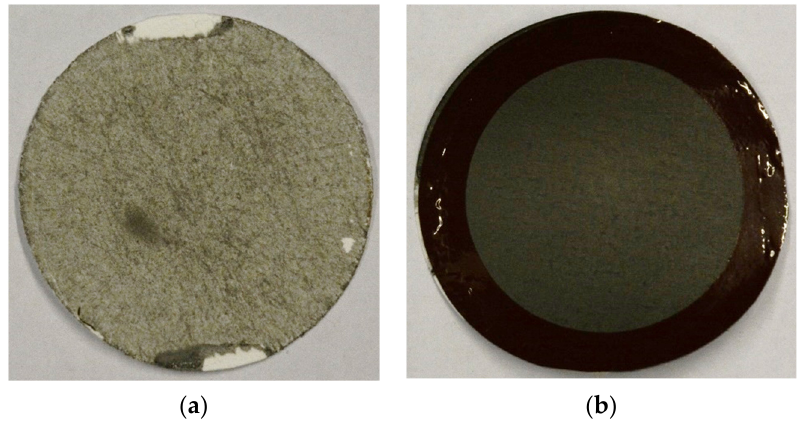
Figure 13. Comparison between membranes coated on untreated ( a ) and treated ( b ) carriers.